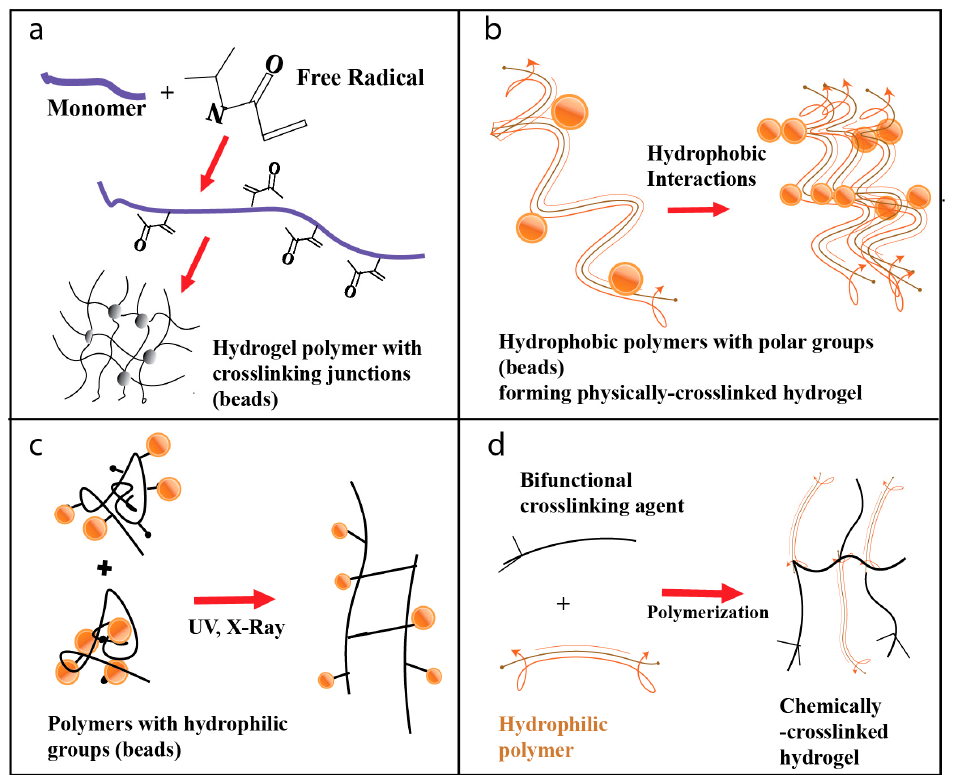
Figure 1. Synthesis of hydrogels in ( a ) free radical polymerization, ( b ) physical cross-linking, ( c ) irradiation cross-linking, and ( d ) chemical cross-linking.